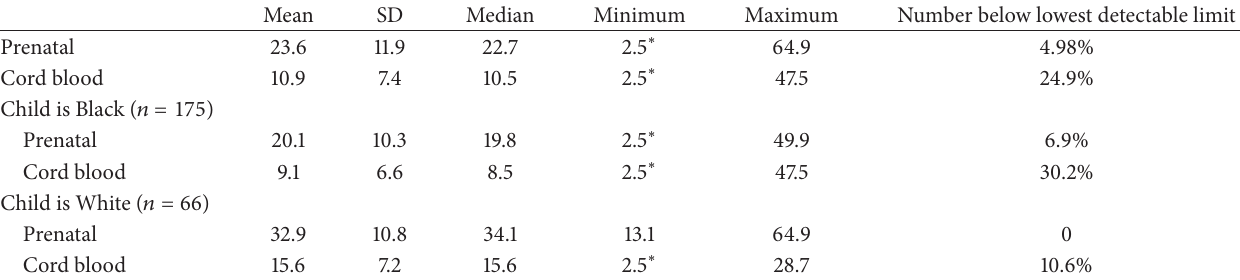
Table 1: Descriptive information for 25(OH)D levels in the 241 maternal-child pairs. Values are given in ng/mL ∗ .